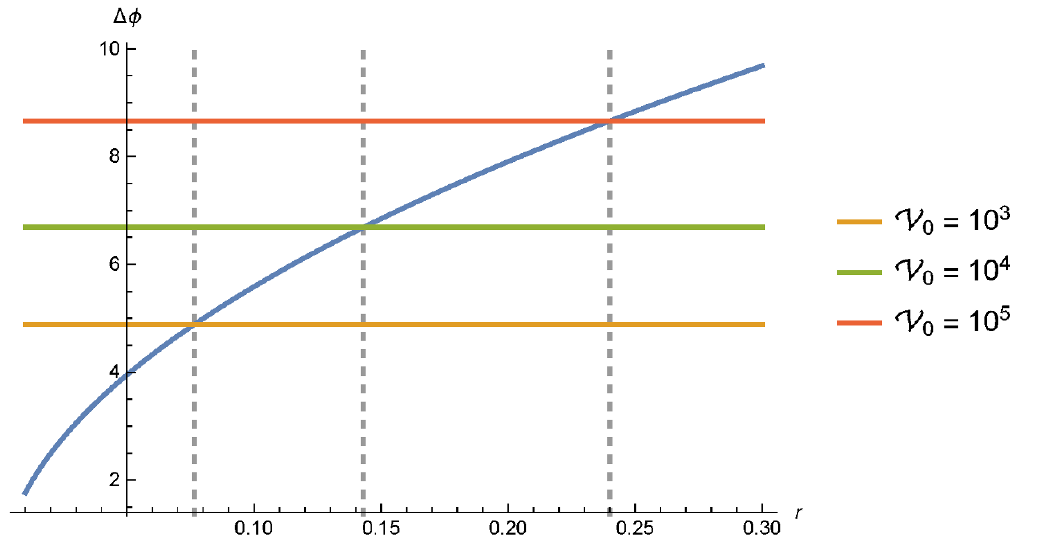
Figure 4 . In(cid:13)aton range (cid:1) (cid:30) in units of M p as a function of the tensor-to-scalar ratio r for constant r , and corresponding upper bounds for g s = 0 : 3, N e = 50 and V